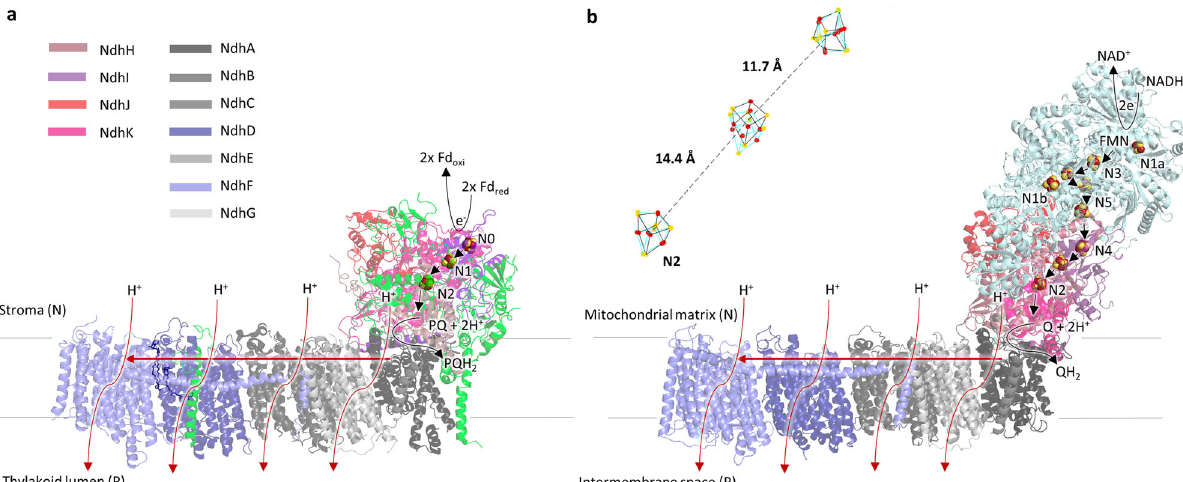
Fig. 1 Structural and functional comparison of PS-CI and R-CI. a Structure and proposed catalysis of T. elongatus PS-CI (Photosynthetic complex I) (PDB: 6HUM). The 11 core subunits are coloured as indicated; the seven oxygenic photosynthesis-speci fi c (OPS) subunits are in green; reactions are shown schematically. Electron transfer from the donor Fd to the acceptor PQ is indicated by black arrows. The putative movement of protons across (horizontal arrow) and through the membrane domain are indicated by red arrows. b Structure and proposed catalysis of T. thermophilus R-CI (PDB: 4HEA). The analogous subunits to PS-CI are coloured using the same key as in a , all other subunits are pale blue; reactions are shown as in a . FeS clusters in R-CI are labelled according to their EPR signals 73 . b Inset FeS clusters (Fe in red and S in yellow) of PS-CI (black, PDB: 6HUM) superimposed with structurally equivalent clusters in R-CI (Respiratory complex I) (cyan, PDB: 4HEA). Centre-to-centre PS-CI FeS cluster distances are